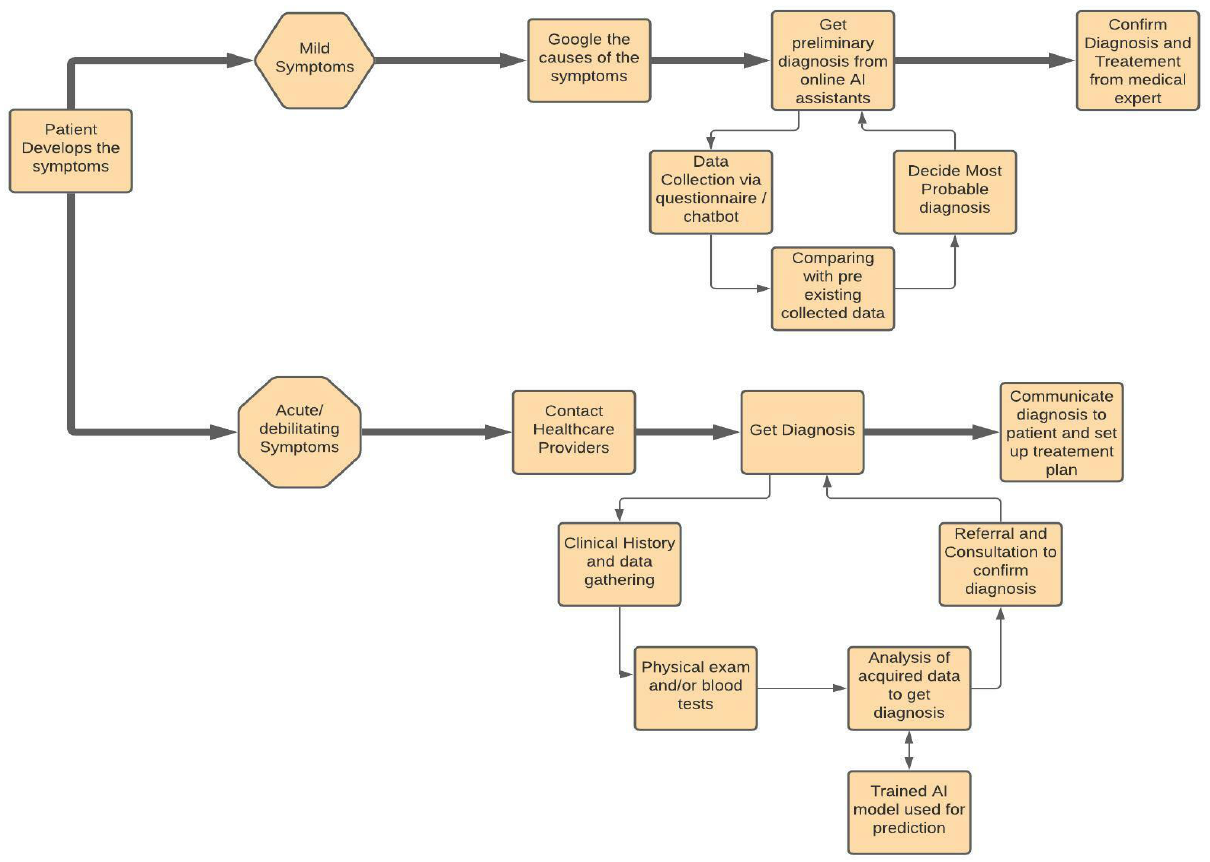
Figure 4. The Process Flow Representation of Diagnosis of Diseases using AI.